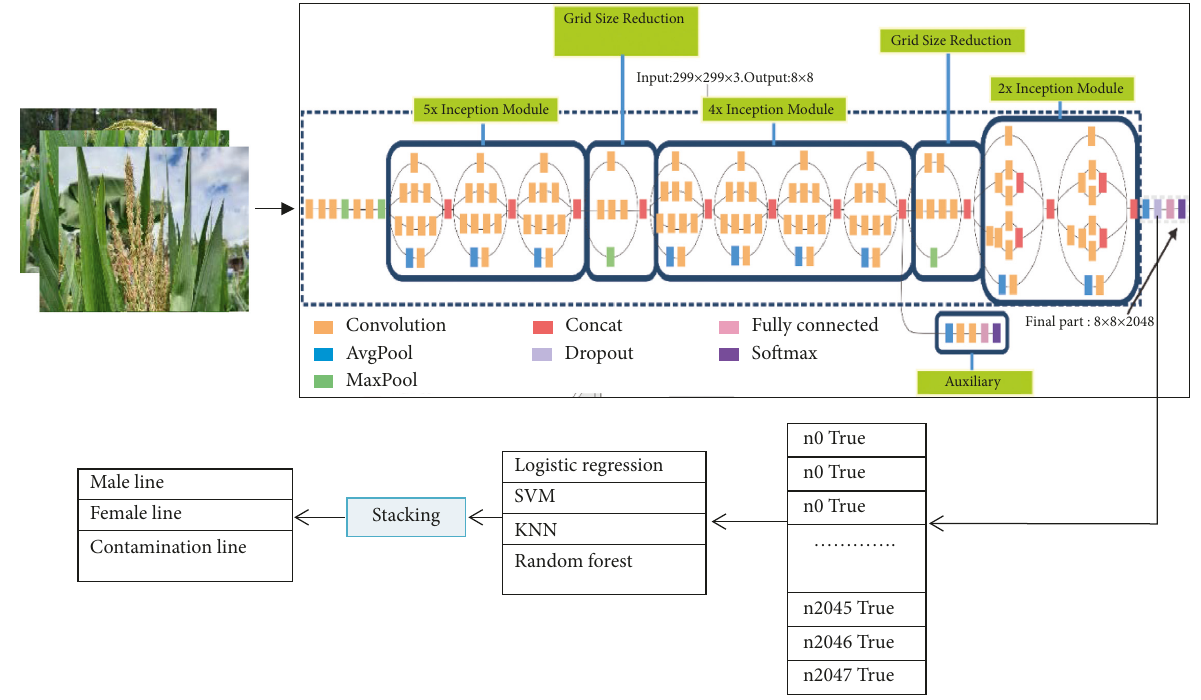
Figure 3: Proposed ensemble process using transfer learning based on the Inception V3 model.